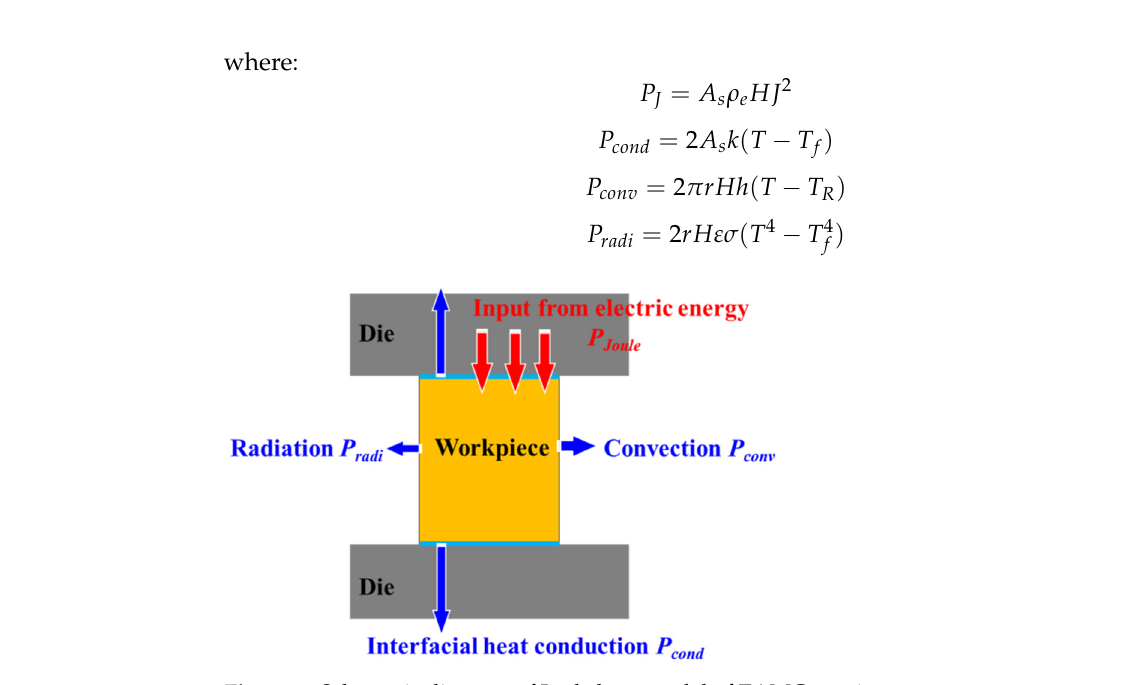
Figure 4. Schematic diagram of Joule heat model of EAMC